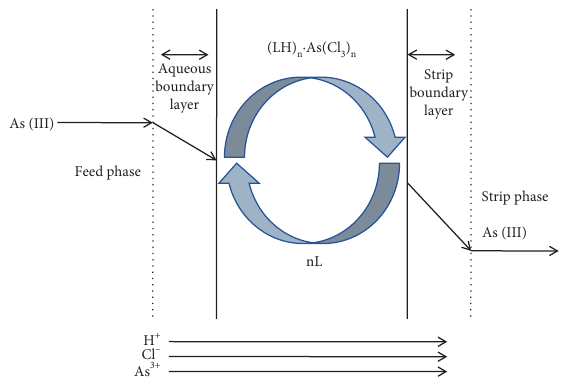
Figure 1: Schematic representation of As (III)